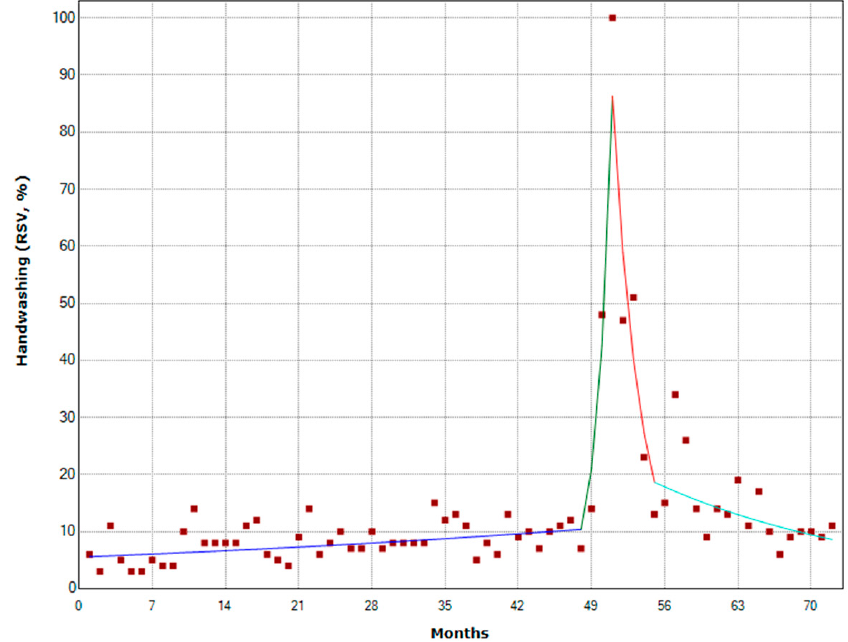
Figure 5. Joinpoint analysis of public interest in the term “handwashing”.